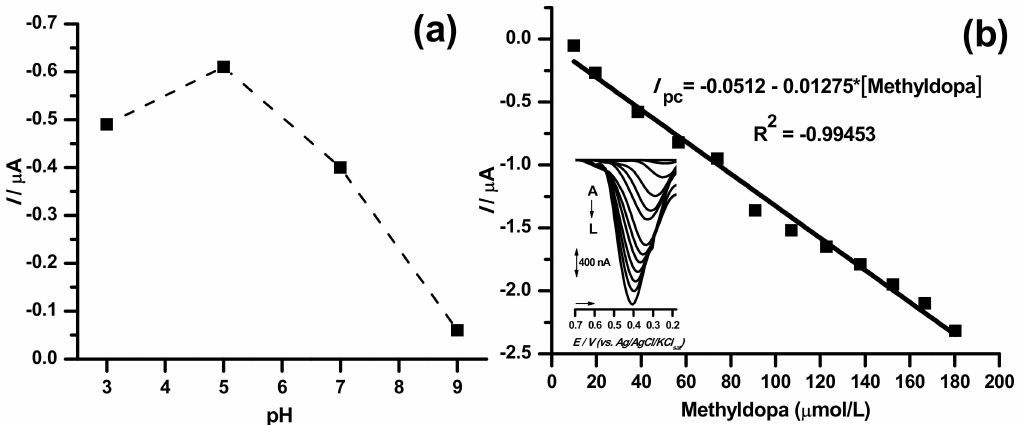
Figure 4. ( a ) pH response study for the TiO 2 @CPE sensor. ( b ) Calibration curve obtained from